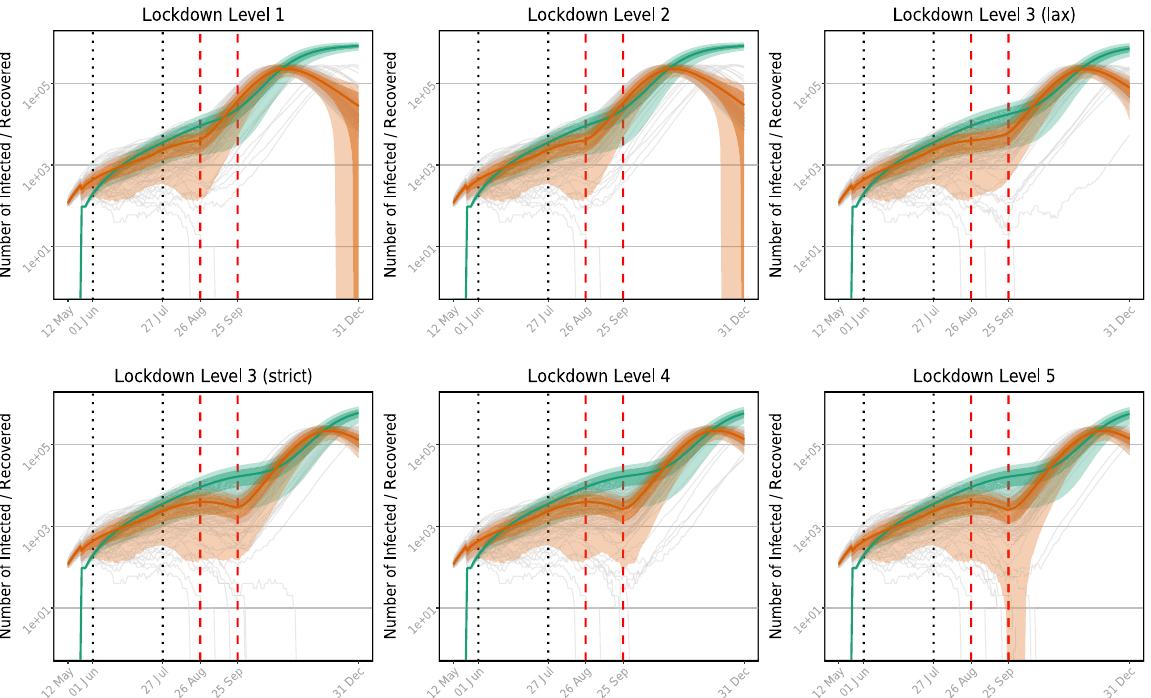
Fig. 7 Simulated infection dynamics in NMBM with an anticipated 30-day-lockdown from 26 August 2020 on. All lockdown measures end after 30 days on 25 September 2020. The six panels refer to the different policy scenarios ranging from level 5 (very strict lockdown) to level 1 (no lockdown measures). The grey lines represent the case numbers of 100 simulations with various seeds for each policy scenario. The coloured lines denote the mean total number of active infections (orange) and the mean cumulative number of recovered infections (green), respectively. The con fi dence intervals are computed at a 50% and an 80% level. The vertical lines denote the dates of earlier governmental lockdown measures (black, dotted) and the simulated measures of 30 days (red, dashed). On 1 June 2020, the lockdown measures were relaxed from level 4 to level 3. On 27 July 2020, lockdown level 3 remained active, but schools were closed again and several other restrictions were in placed such as alcohol selling bans (referred to as lockdown level 3 (strict)).